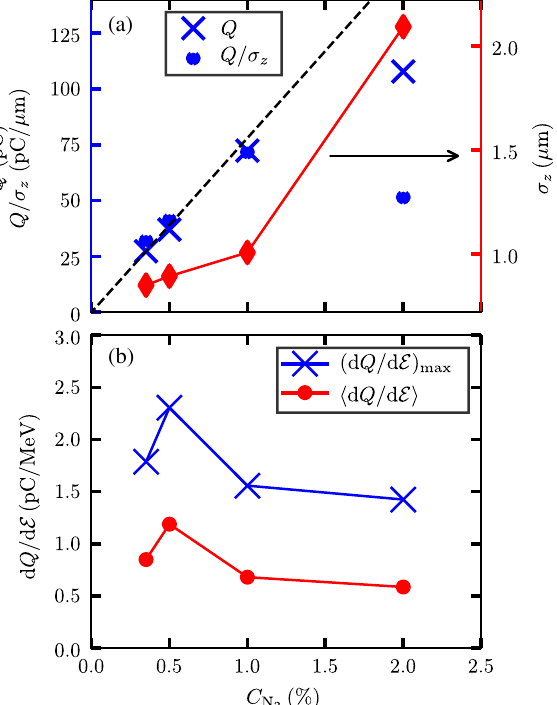
FIG. 8. Accelerated beam charge with respect to C . (a) On the N 2 left axis: Charge Q (blue crosses) and linear charge density Q= σ z (blue dots) on the right axis with respect to C , the black dashed N 2 lie represents a linear regression of Q with respect to C passing . N 2 N 2 ¼ 0 . 35% . On the right axis: Electron rms by the value Q at C N 2 bunch length σ z with respect to C ; (b) Maximum charge N 2 density ð d Q= d E Þ (blue crosses) and average charge density max h d Q= d E i (red . N 2